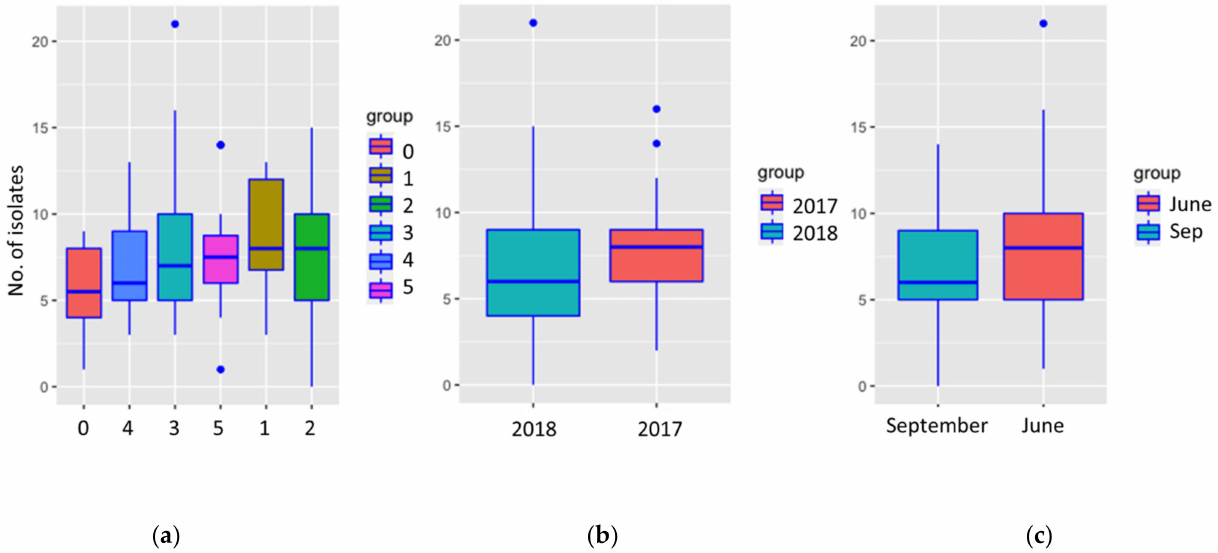
Figure 9. The number of occurrences of Sphaeropsis sapinea in different disease classes ( a ), growth years ( b ), and sampling times ( c ) in the culture-based isolation